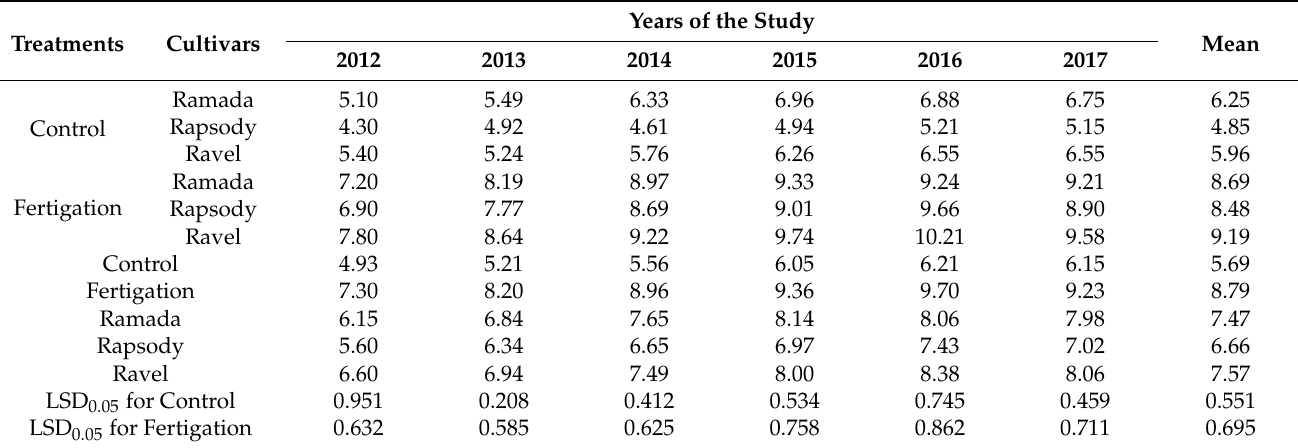
Table 5. The marketable yield (t ha − 1 ) of green spears of